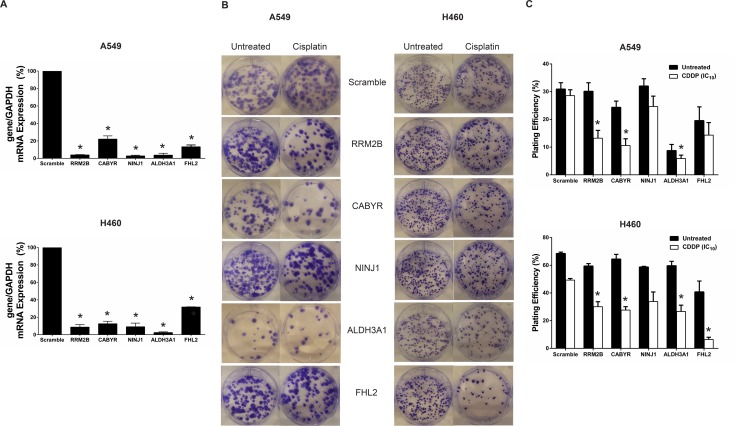
Validation studies assessing the effects of ALDH3A1, RRM2B, CABYR, FHL2, and NINJ1 silencing on cisplatin activity in A549 and H460 cell lines.Knockdown of each candidate target was confirmed via qPCR (A; *p<0.05 relative to scramble control). The representative image for each tested condition is displayed in B. The plating efficiency of each condition is plotted in separate graphs for each cell line (C; data shown as mean ± SEM; n = 3; *p<0.05).